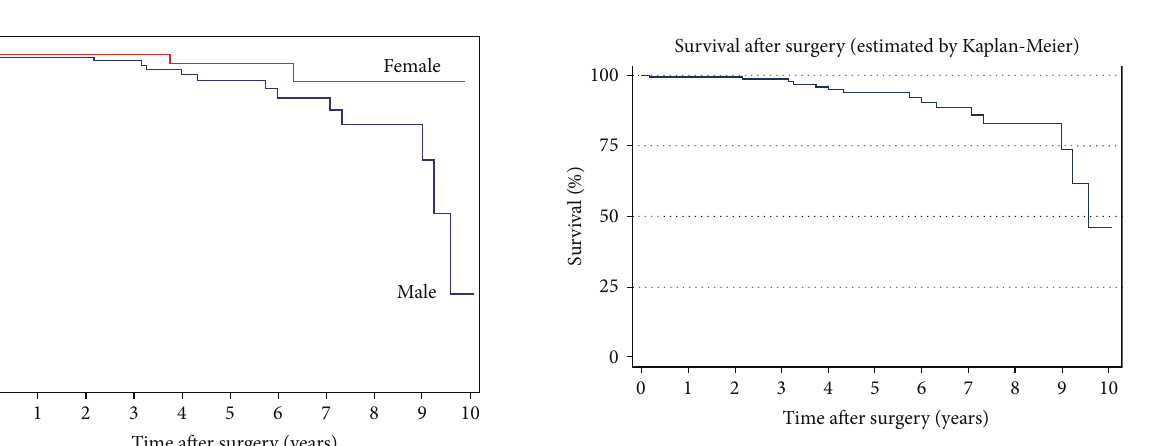
Figure1:SurvivalofPDpatientsbygender.Coxregressionindicates